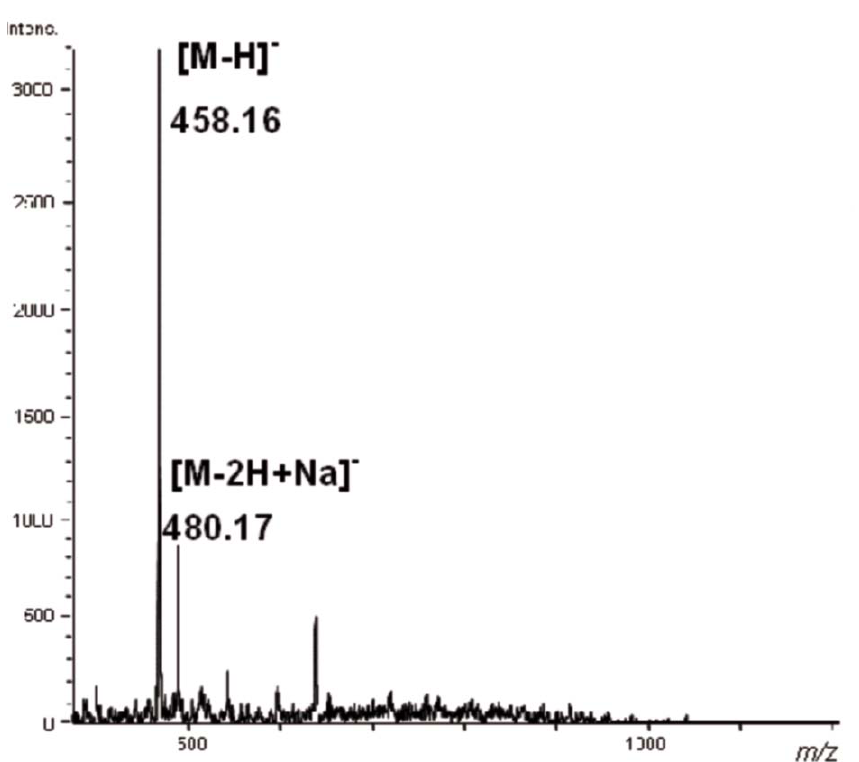
Figure 5. Fully automated chip (-) nanoESI HCT CID MS of monosulfated standard CS disaccharide having the composition [4,5 Δ -GlcA-GalNAc] (4S). Conditions as for the experiment in Fig. 2.